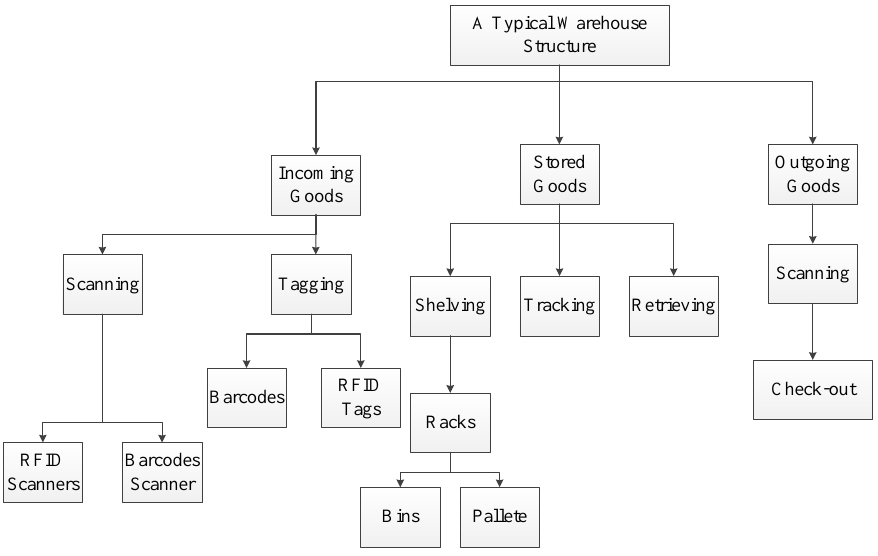
Figure 1. A generic display of the departments in a